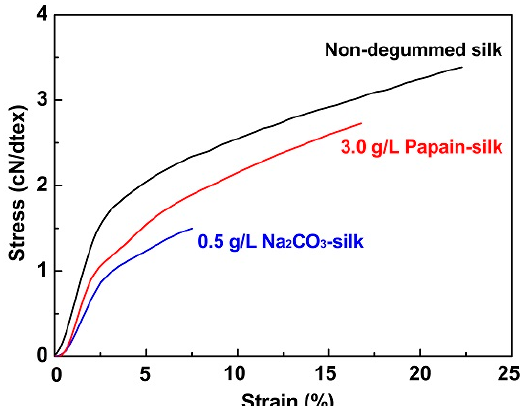
Figure 4. Stress-strain curves of sericin-free silk fibers prepared by two degumming methods, with non-degummed raw silk as a control. Table 1. Mechanical properties of silk fibers treated by two degumming methods ( n = 20).